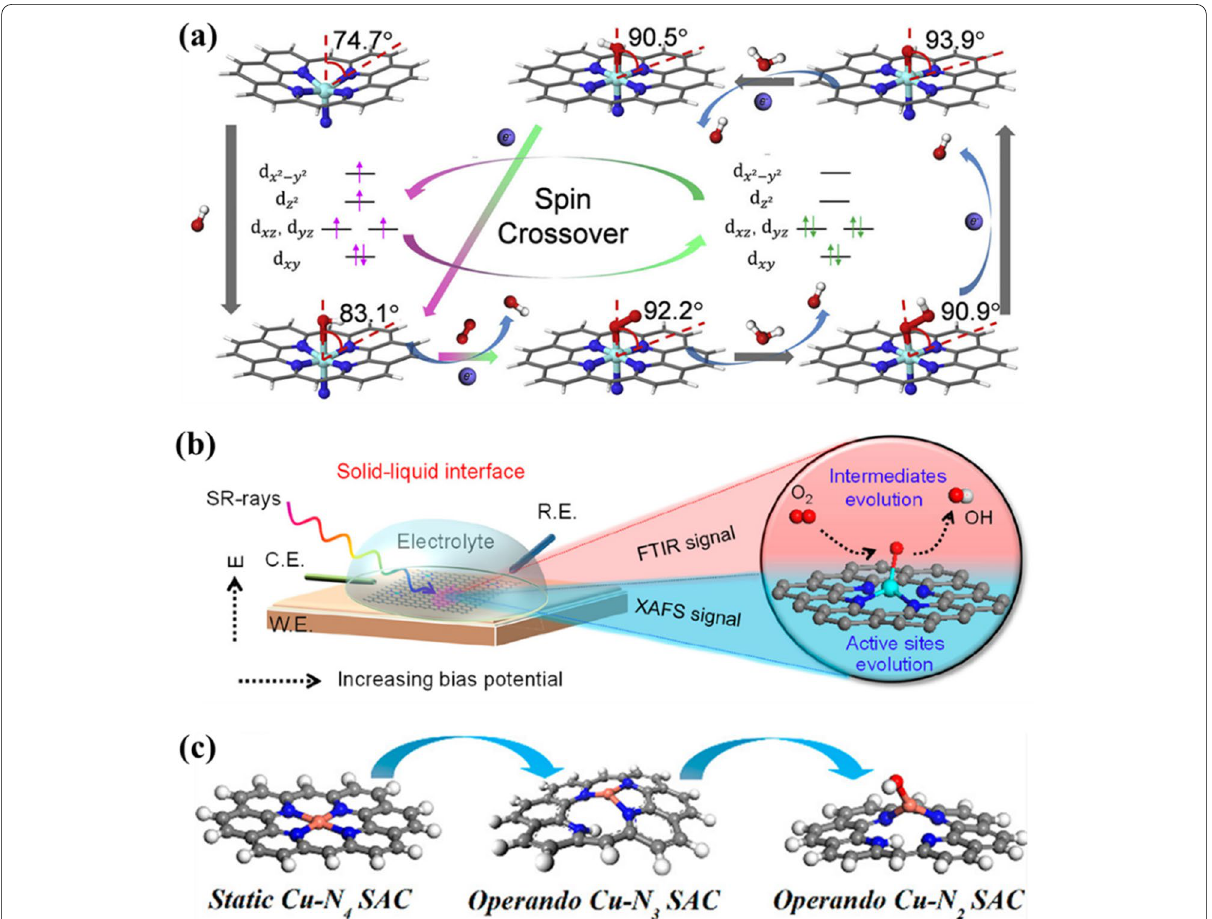
Fig. 5 a Structural and dynamics of Fe‑N 5 C 10 site in electrocatalytic ORR. b Schematic illustration of the operando synchrotron characterization (C.E., counter electrode; R.E., reference electrode; W.E., working electrode) and the dynamic evolution of Ni‑N 4 site. c Schematic illustration of the dynamic evolution of Cu‑N 4 site. a Reproduced with permission from Ref. [99]. Copyright 2020, Elsevier. b Reproduced with permission from Ref. [100]. Copyright 2020, American Chemical Society. c Reproduced with permission from Ref. [101]. Copyright 2021, American Chemical